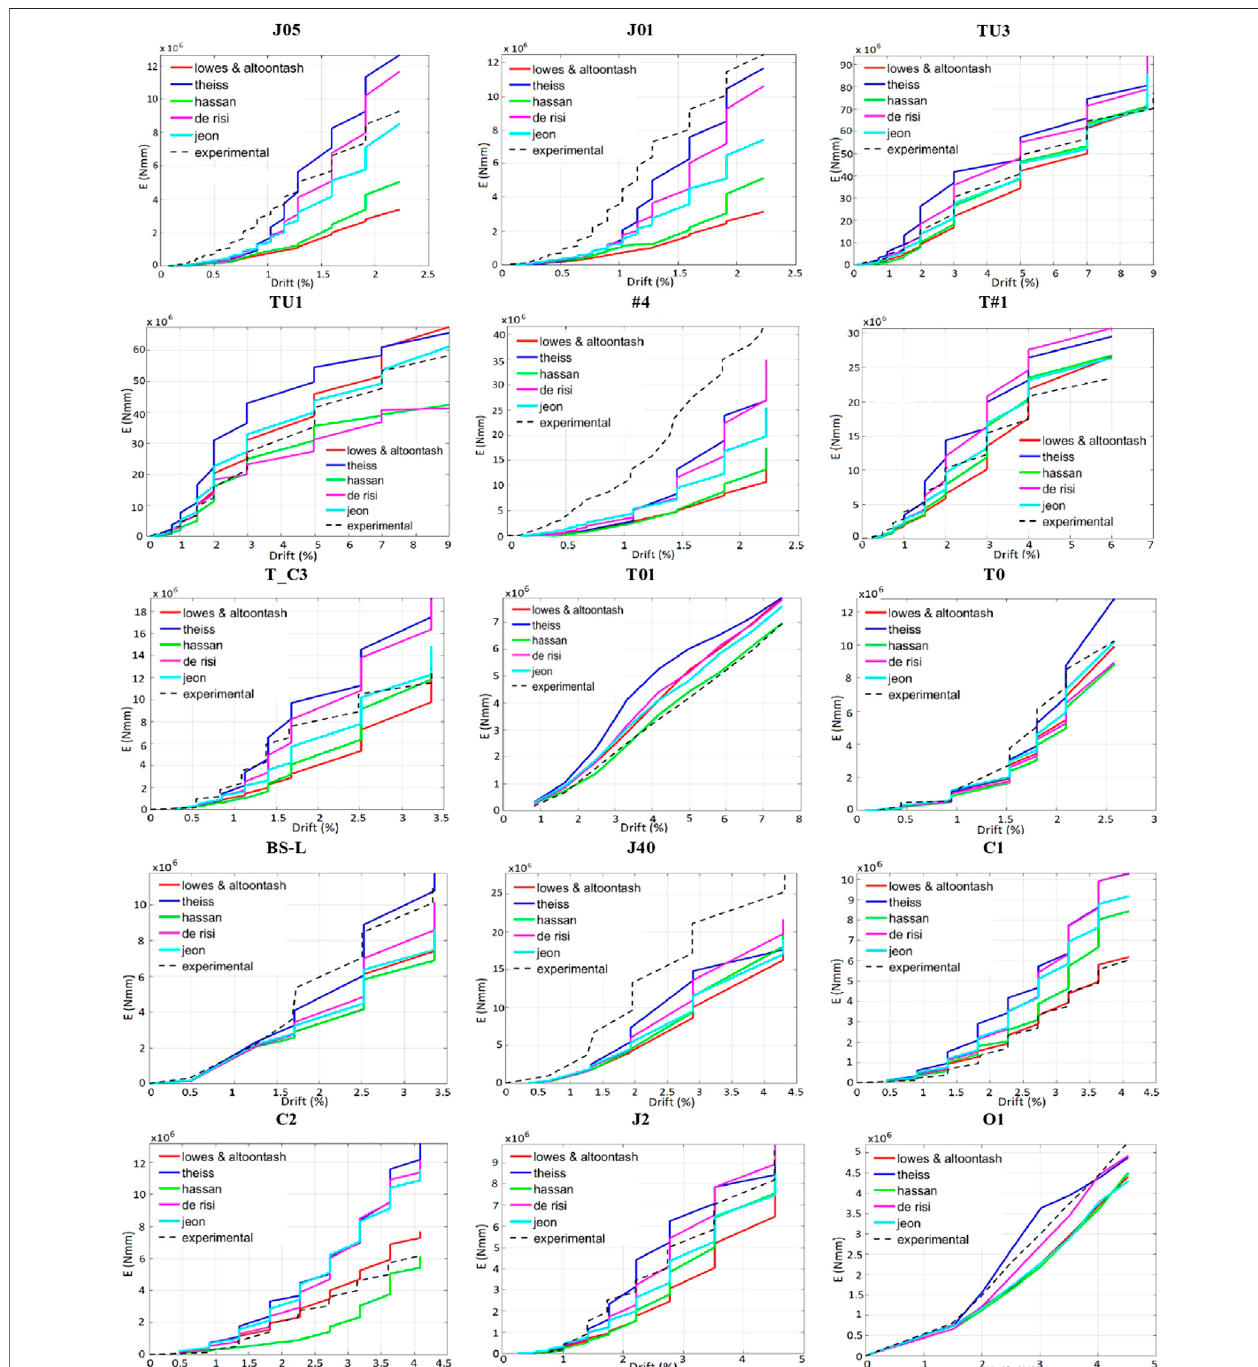
FIGURE 11 | Cumulative dissipated energy: comparison among the literature